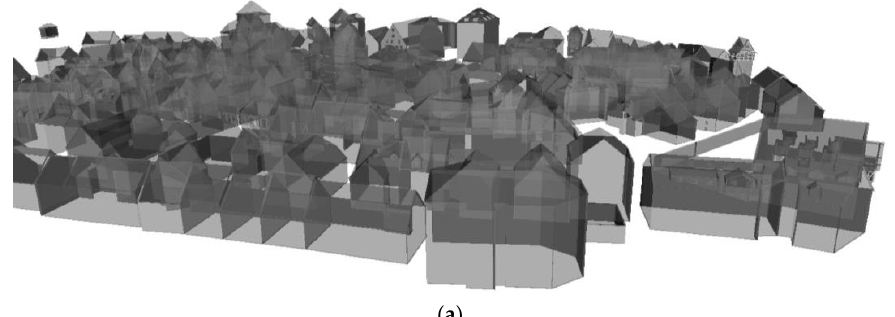
Figure 11. Exterior shell representation of a 3D city model (LOD3ES).